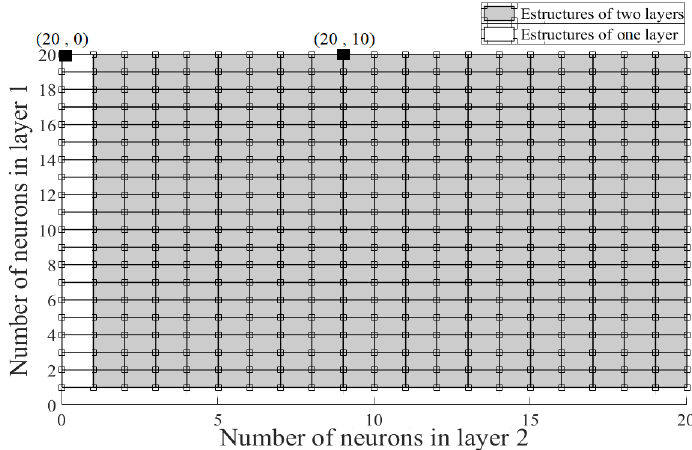
Figure 4. Search grid of the optimal neural network structure. Source: [16].